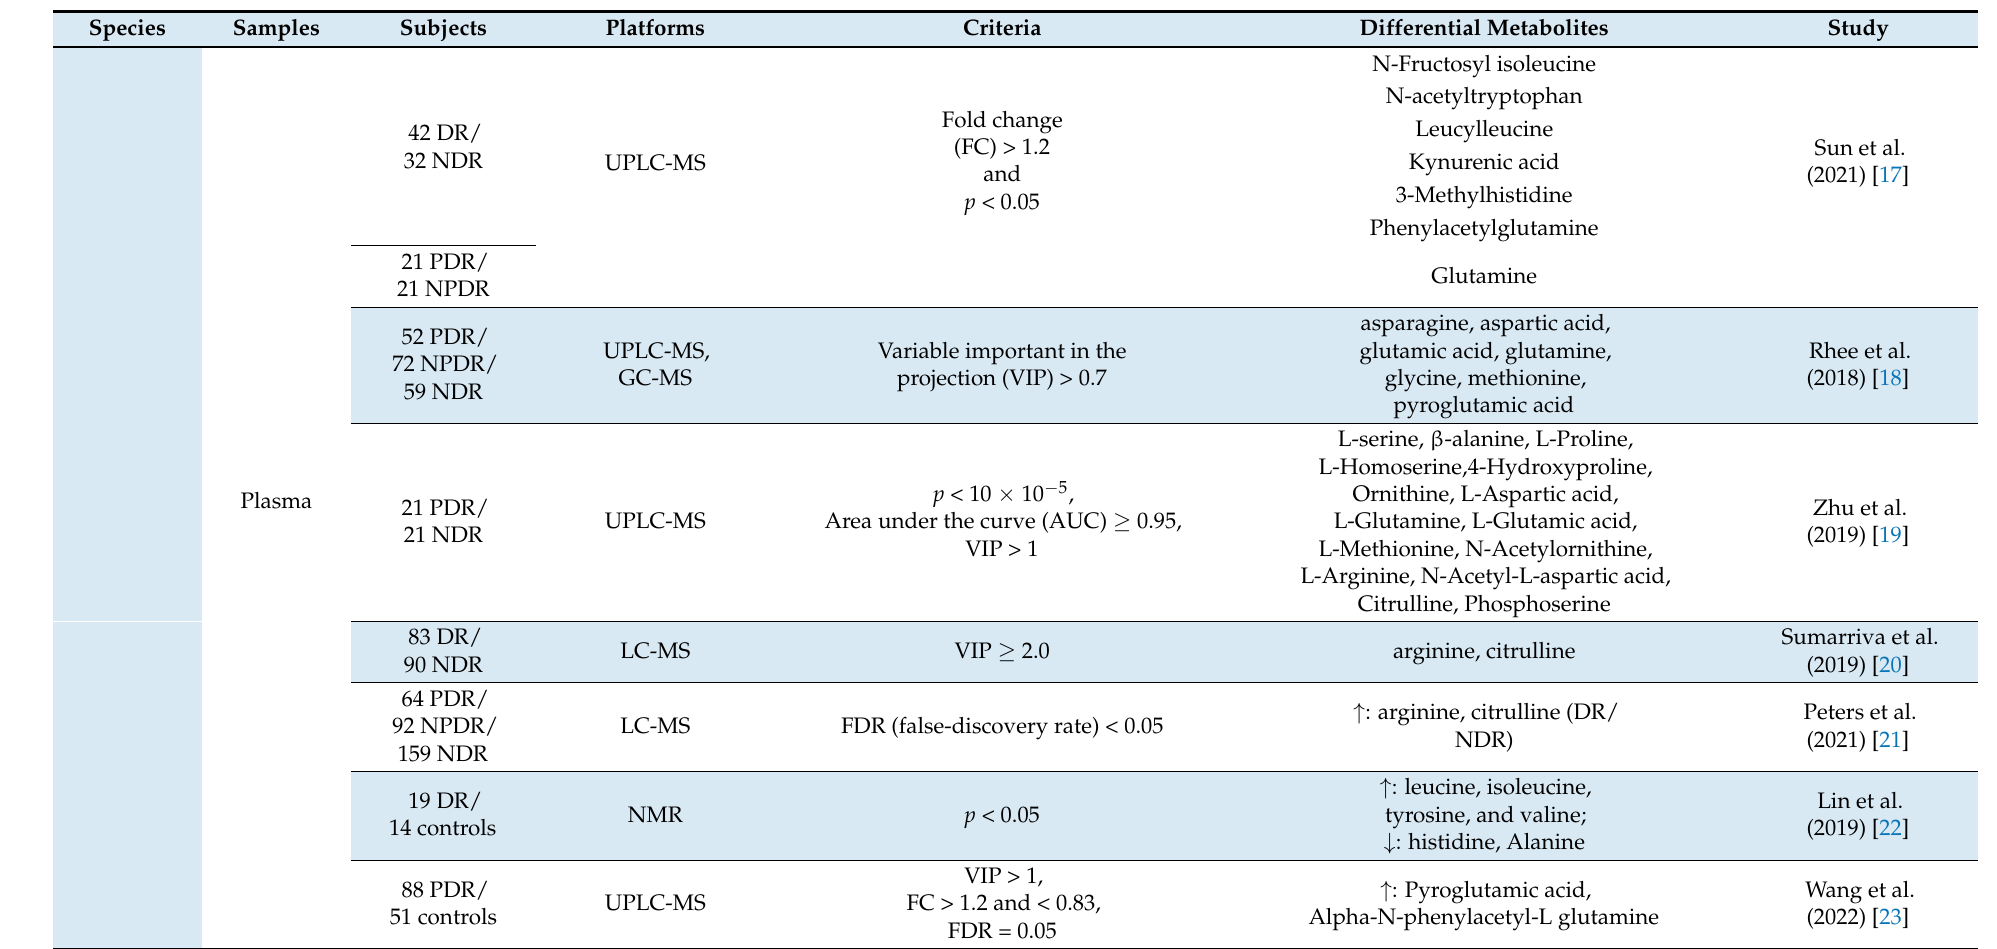
Table 1. Summary of amino acids in diabetic retinopathy based on metabolomics